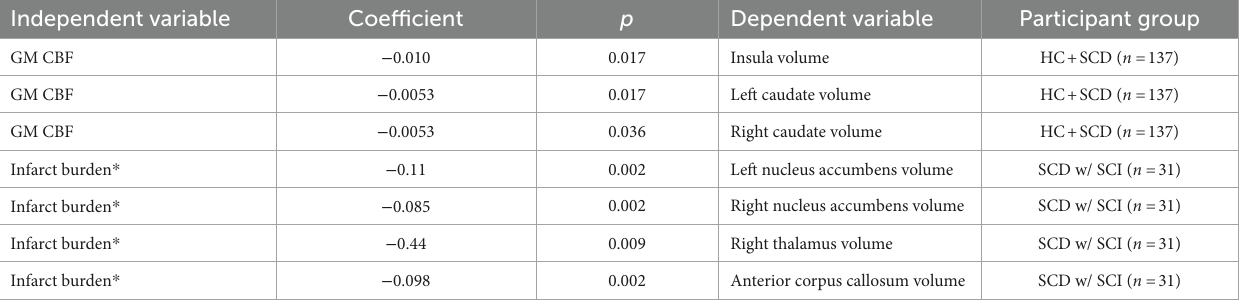
TABLE 3 Components of multivariable linear regression models for predicting cortical and subcortical structure volumes, organized by independent variables of interest. Independent